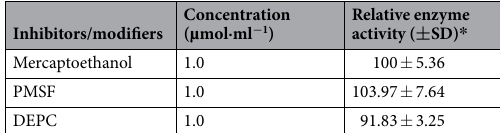
Concentration ( µ mol·ml − 1 )